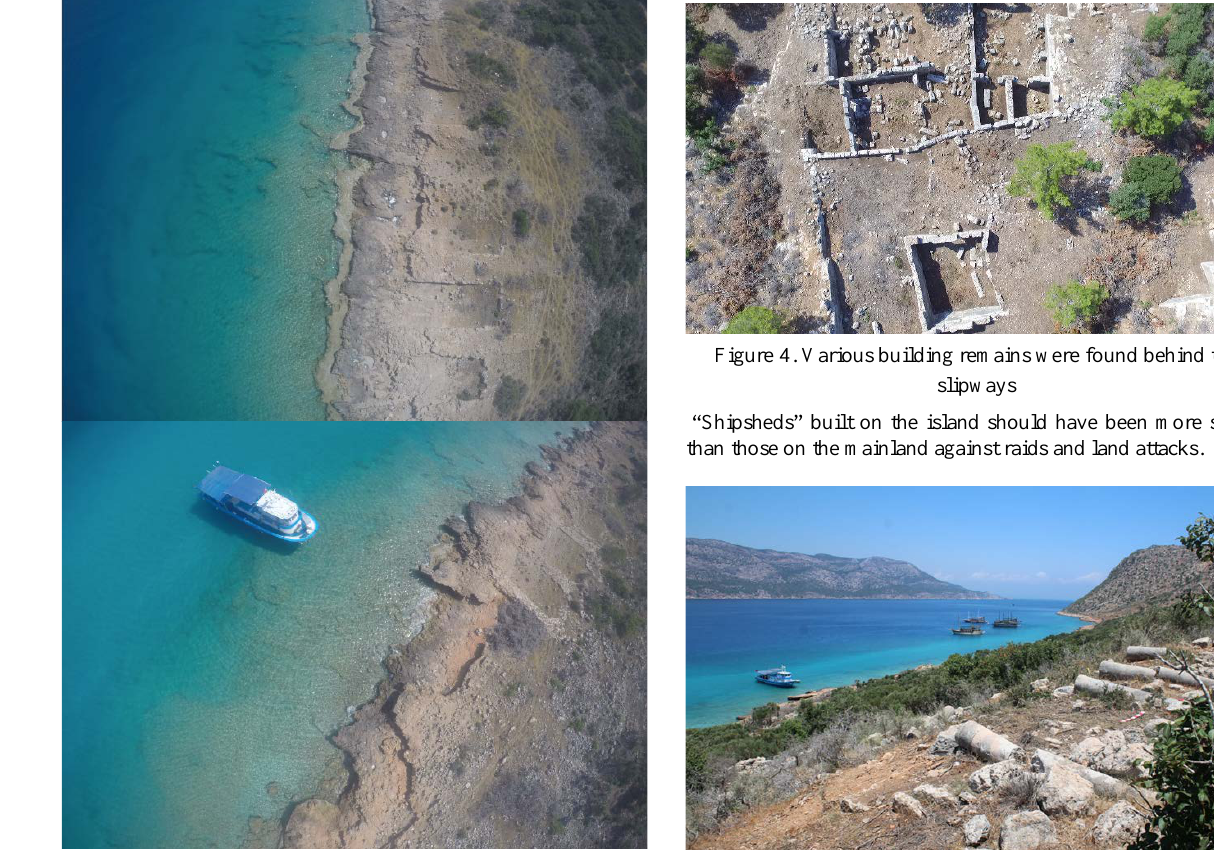
Figure 2. Aerial view of the slipways side by side